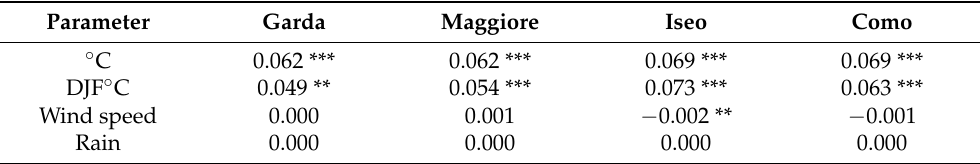
Figure 4. Trend in the coefficient of the squared term of a second-order polynomial calculated per year between April and October for the four lakes. A change from a positive to negative reflects a change from a concave to a convex curve. Values not calculated where n < 4. Grey areas reflect 95% confidence interval. Table 3. Sen slope results on annual data from 1980–2018. *** = p ≤ 0.001, ** = p ≤ 0.01.